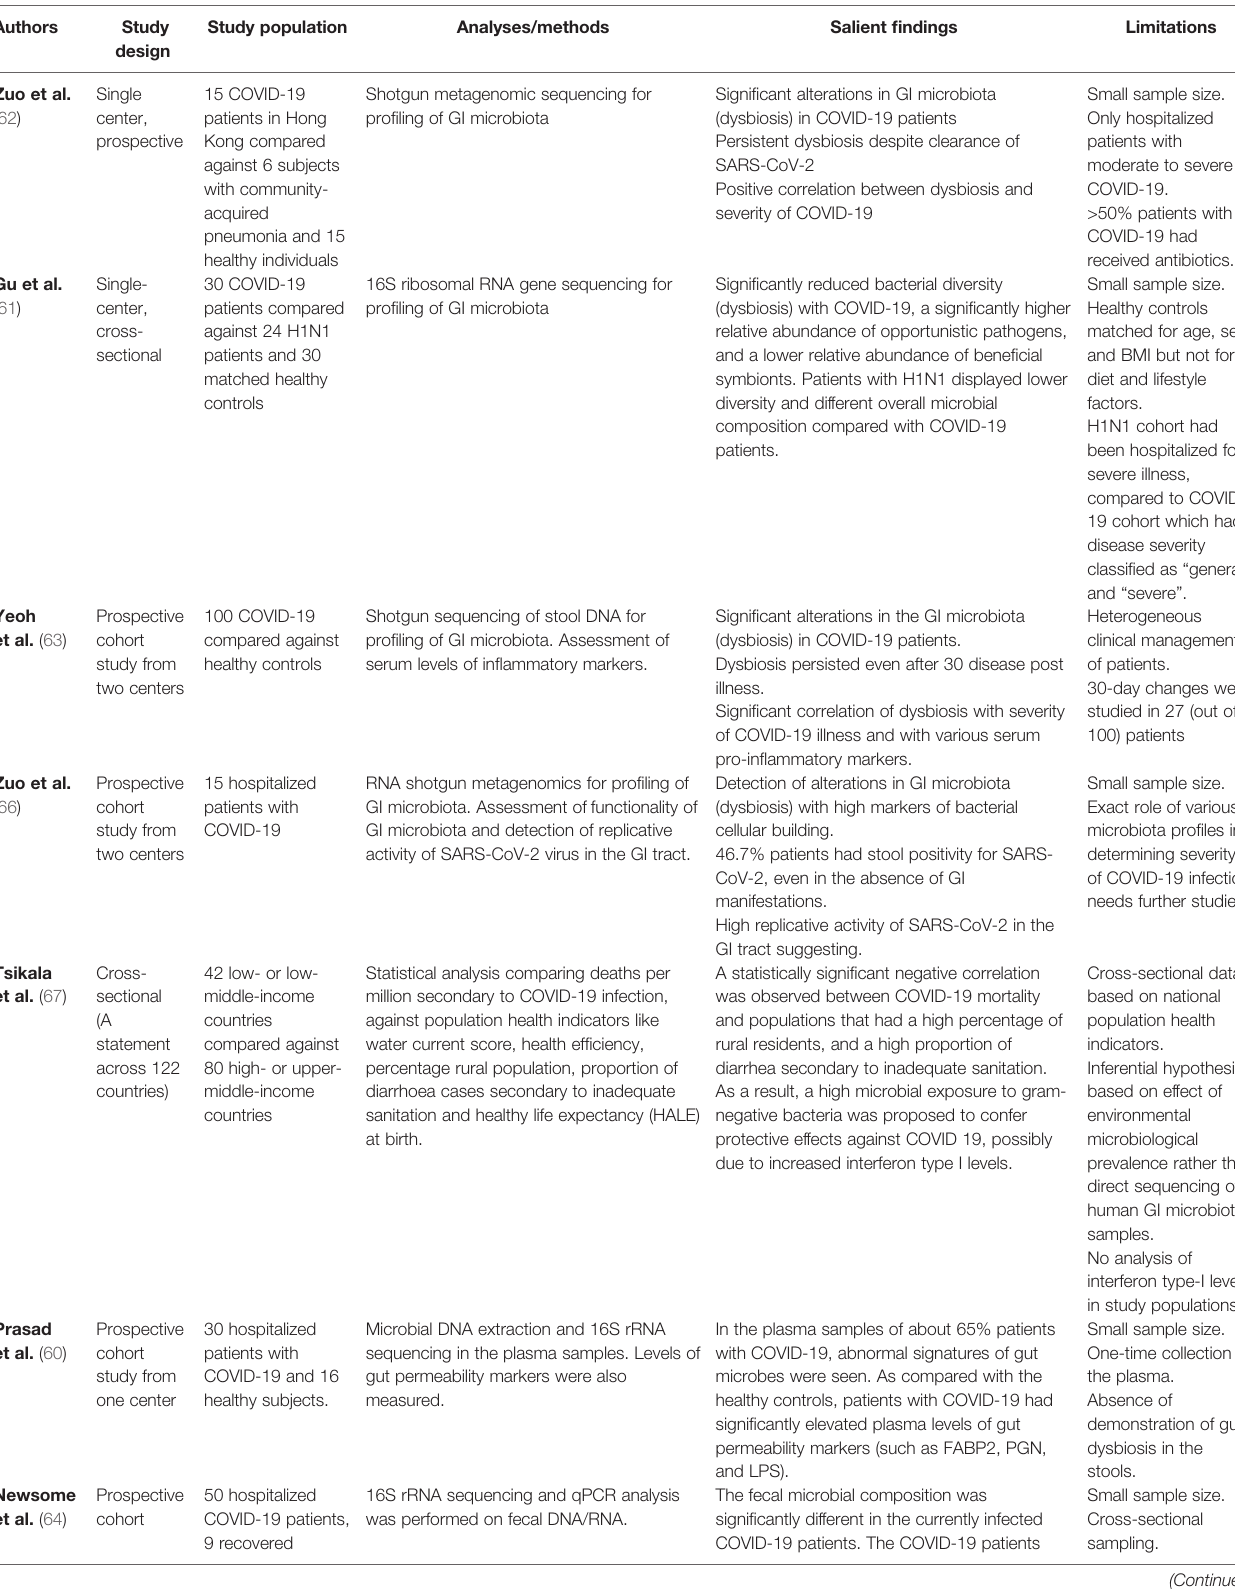
TABLE 1 | Studies exploring the role of gut microbiota in